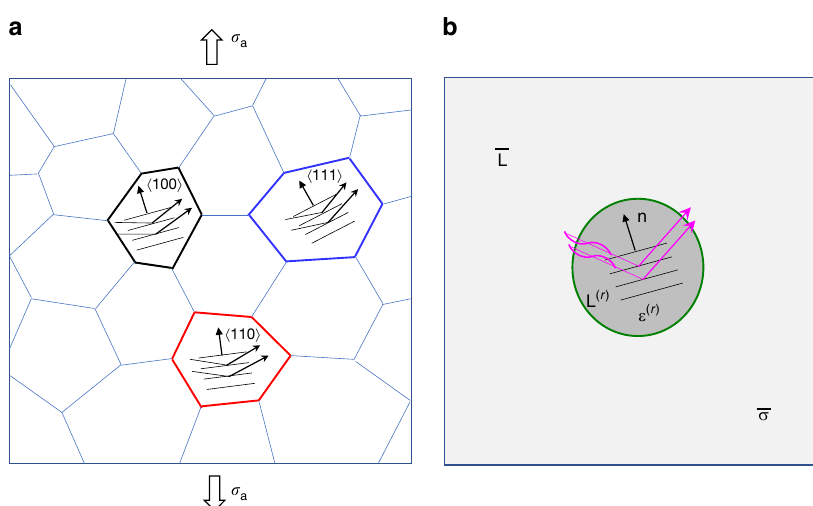
Fig. 4 Schematic illustration of the micromechanics model of a polycrystalline aggregate. a Polycrystal consisting of different { hkl } grain families oriented along the uniaxial loading direction. For example, the {111} grain family refers to a set of grains with the unit normal vector n of {111} planes along the loading direction. X-rays re fl ected by the { hkl } planes are collected to track the average interplanar spacing of these { hkl } planes with deformation due to applied stress σ a . b In the self-consistent polycrystal model, each single-crystal grain is approximated as a spherical inclusion with the anisotropic elastic stiffness tensor L ( r ) embedded in a homogeneous matrix with the effective stiffness tensor (cid:1)